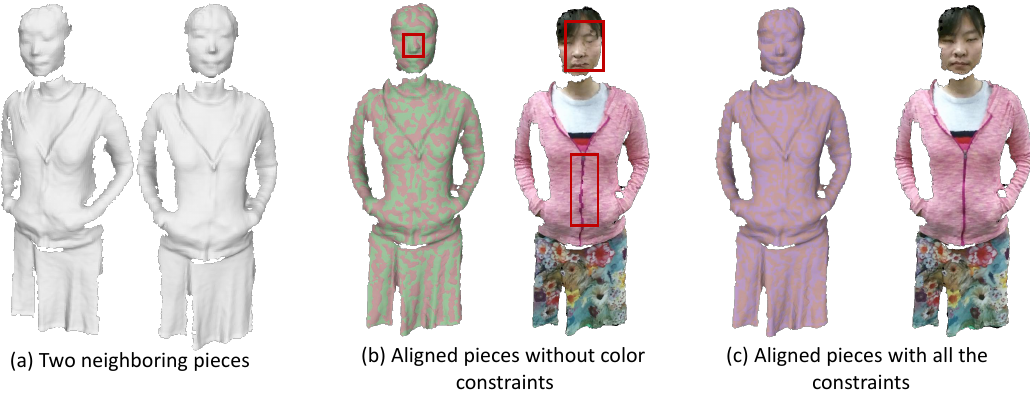
Figure 4. Illustration of pairwise alignment results. ( a ) two neighboring pieces achieved from the above partial piece generation step; ( b ) the alignment results without the color information. These two pieces are shown with different colors in the left of ( b ) so that we can see the alignment result more clearly. The misalignment in the appearance is visualized in the right figure of ( b ) where the two meshes colored by the captured color images are overlaid; ( c ) demonstrates the alignment result with all those constraints in Equation (2) where we can see that the two meshes are